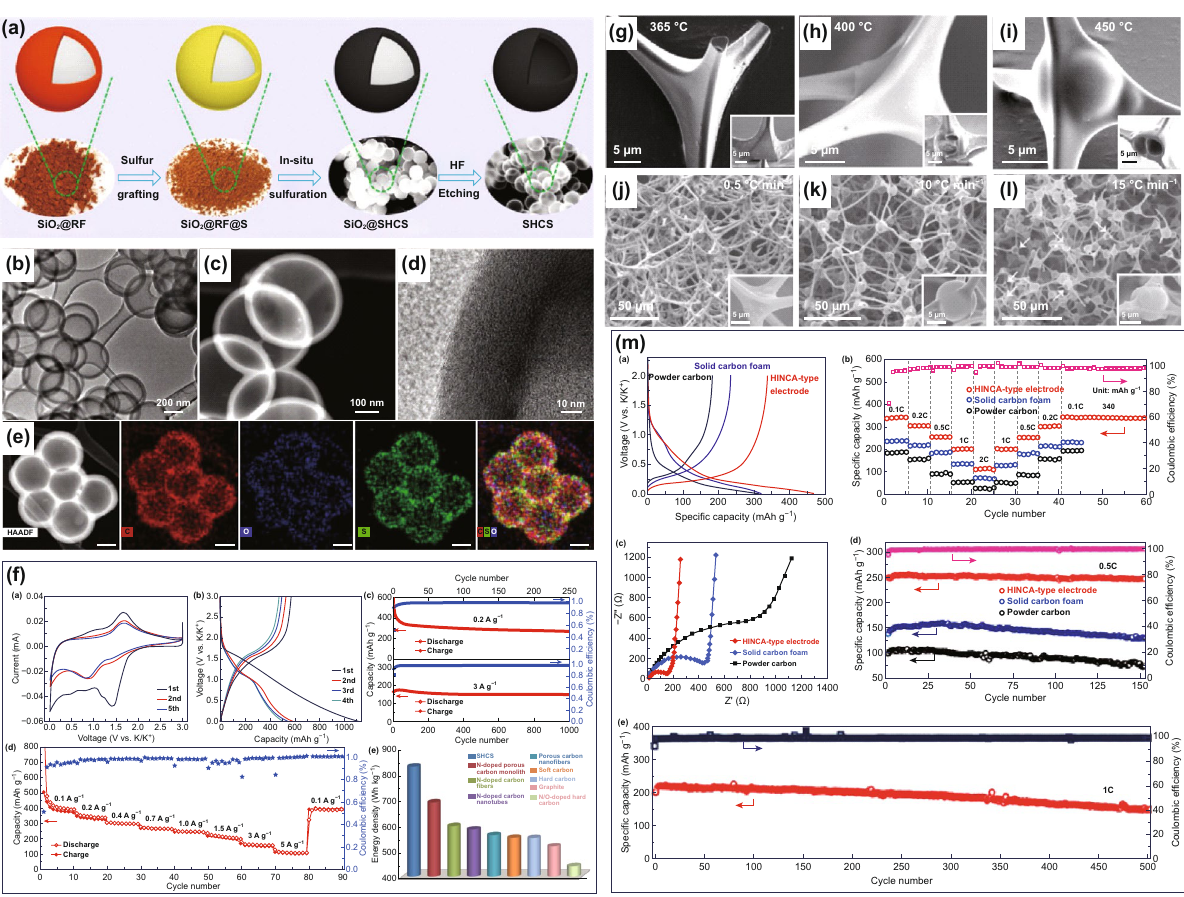
Fig. 10 a Illustration of the synthesis route of SHCS. b , c TEM images, d HRTEM image, and e HAADF image and elements mapping of SHCS. f Electrochemical performance of SHCS electrodes for PIBs. Reproduced with permission from Ref. [156]. Copyright 2019, Wiley– VCH. SEM images of morphological change with temperatures of g 365, h 400, and i 450 °C. SEM images of the carbon products with heating temperature rates of j 0.5, k 10, and l 15 °C min −1 . m Electrochemical performance of the HINCA-type, solid carbon foam, and carbon powder electrodes for PIBs. Reproduced with permission from Ref. [159]. Copyright 2018, American Chemical